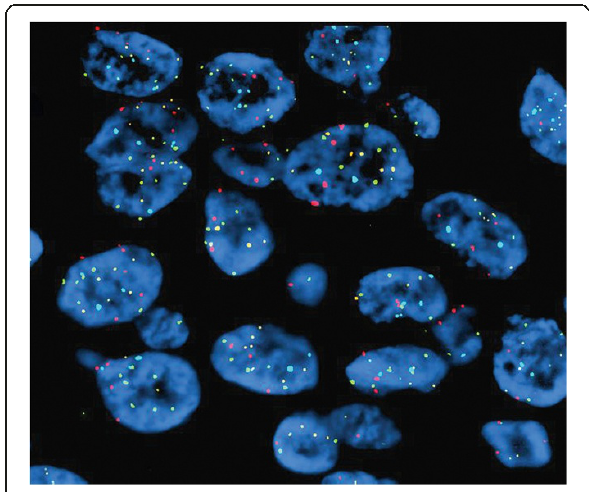
Figure 5 Primary bladder adenocarcinoma. FISH using UroVysion probe set demonstrates a polysomy pattern with more than 2 red, green and aqua signals. (Red – CEP3, Green – CEP7, Aqua – CEP17 and Yellow – LSI 9p21, x600).